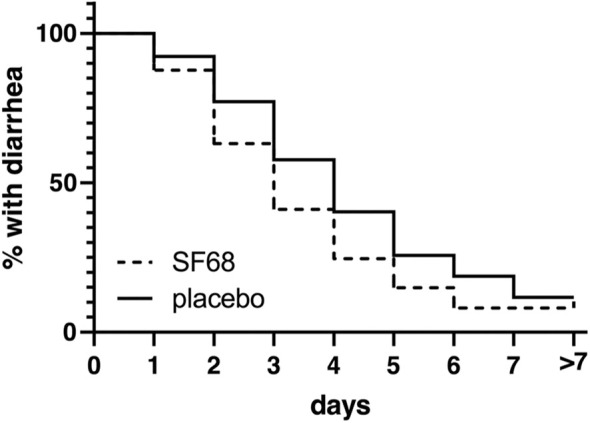
Time to resolution of diarrhea (defined as ≥3 stools per day or liquid or semiliquid stools) in the randomized-controlled treatment trial, shown as Kaplan-Meier curve [log-rank test p < 0.0001 for SF68 vs. placebo; hazard ratio 0.7363 (confidence interval 0.6491-0.8353)].